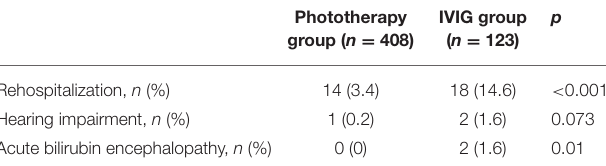
TABLE 2 | Outcomes of infants.